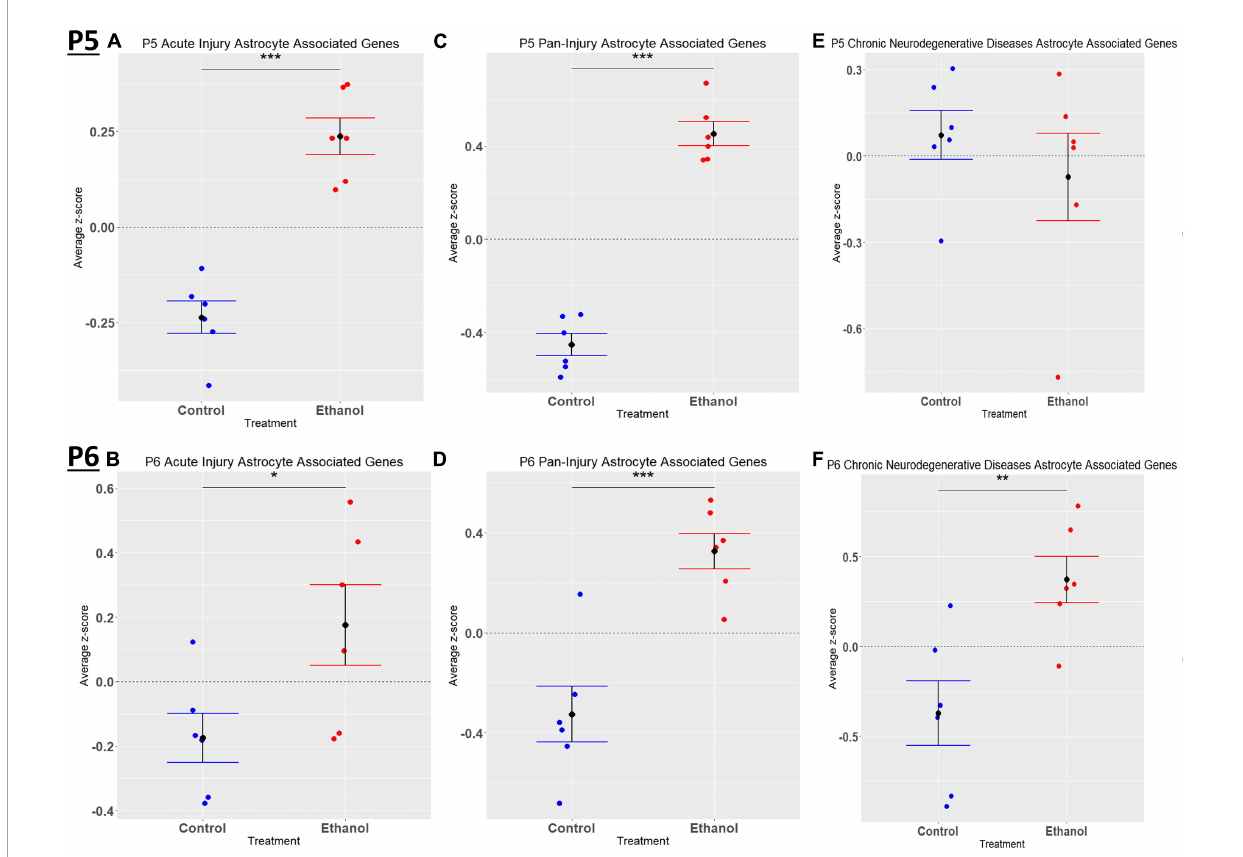
FIGURE6 Astrocyte associated genes altered by ethanol exposure at P5 and P6 in the cerebellum. Astrocyte associated genes were extracted as detailed in Methods. R statistical software was utilized to generate individual z -scores for each transcript of interest and each experimental animal. These z -scores were then averaged across transcripts for each individual animal. Quantification by average z -score of acute injury astrocyte associated genes at P5 (A) and P6 (B) , pan-injury astrocyte associated genes at P5 (C) and P6 (D) , and chronic neurodegenerative diseases associated genes at P5 (E) and P6 (F) . n = 3 males and 3 females per treatment group E or C; * p < 0.05, ** p < 0.01, *** p <